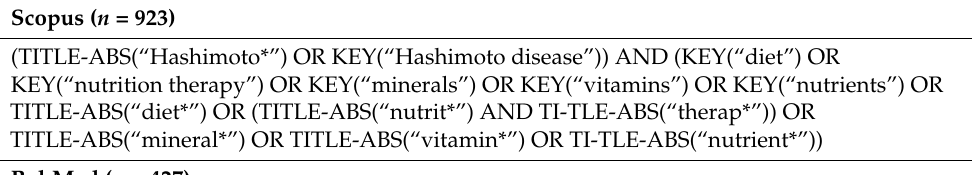
Table 1. Strategy for the primary literature search conducted in PubMed and Scopus databases. Scopus ( n =